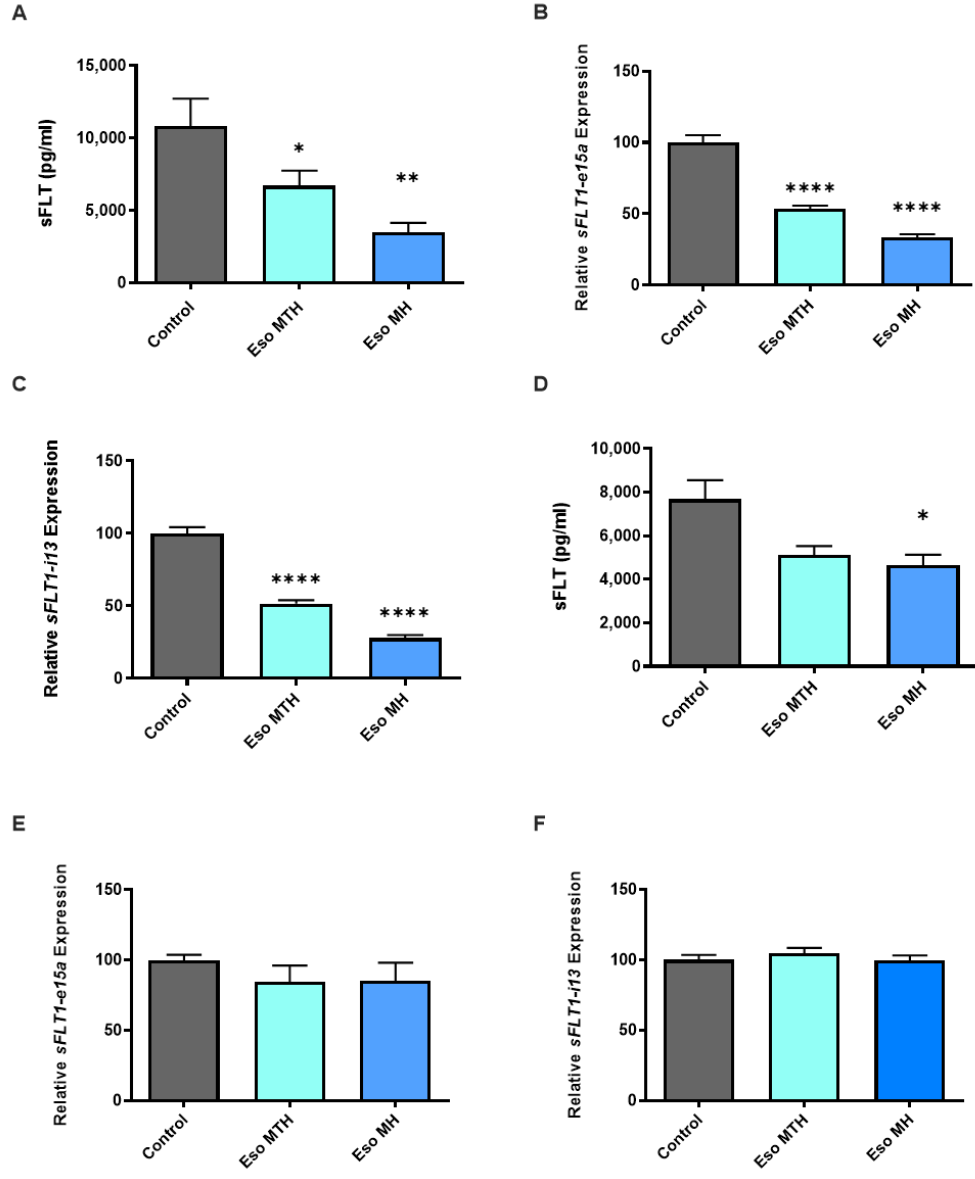
Figure 1. Esomeprazole reduced expression and secretion of the antiangiogenic factor, soluble fms-like tyrosine kinase-1 (sFLT-1) in cultured human placental cells. Esomeprazole magnesium hydrate (Eso MH) and esomeprazole magnesium trihydrate (Eso MTH) reduced secretion of sFLT-1 by primary cytotrophoblast cells ( A ). Both Eso MTH and Eso MH reduced primary cytotrophoblast mRNA expression of the sFLT-1 variants, sFLT1-e15a ( B ), and sFLT1-i13 ( C ). Secretion of sFLT-1 from HUVECs was reduced by treatment with esomeprazole MH only ( D ). There was no alteration in the relative mRNA expression of sFLT1-e15a ( E ) and sFLT1-i13 ( F ) in HUVECs, following treatment with either Eso MH or Eso MTH. Eso MH and Eso MTH were added at 100 µ mol/L concentrations. Data expressed as mean ± SEM ( n = 3). The statistical significance is indicated as follows: * p < 0.05, ** p < 0.01, **** p <